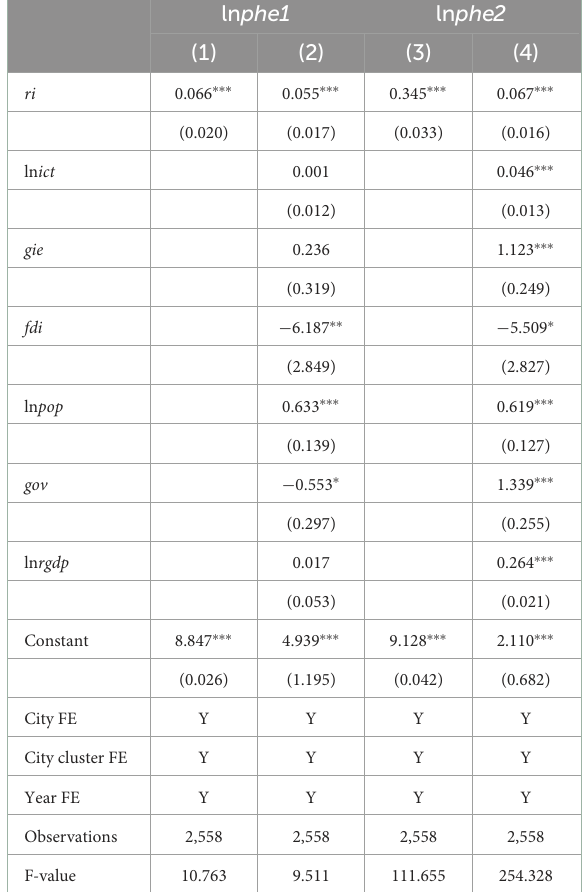
TABLE 8 Re-estimation based on high-dimensional fixed-effects